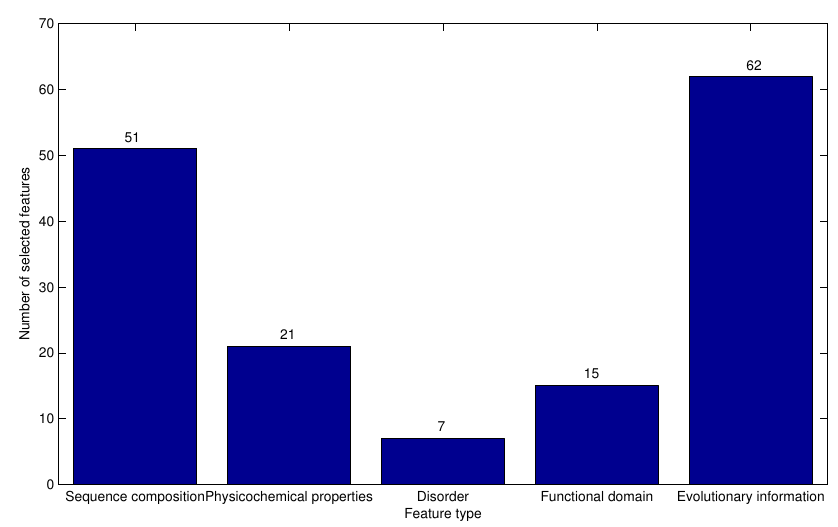
Figure 4. Distribution of each type of feature in the optimal feature set. The five types of features are derived from sequence composition, physicochemical properties, disorder, functional domain and evolutionary information,